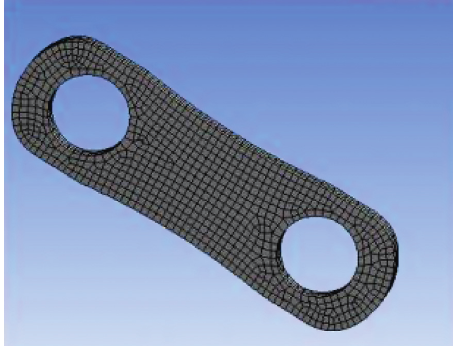
Figure 4: Meshed chain link.